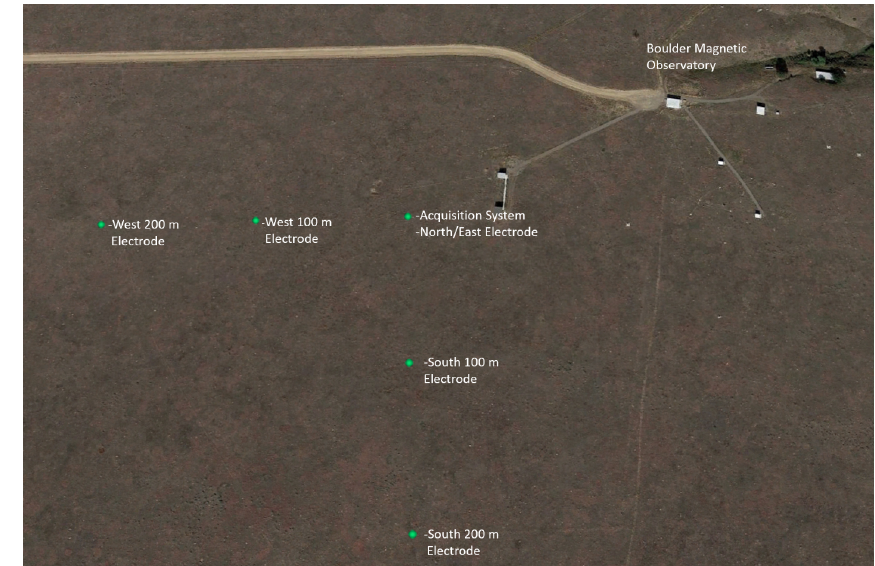
Figure 1. Map of geoelectric monitoring deployment at the Boulder observatory. North is up.